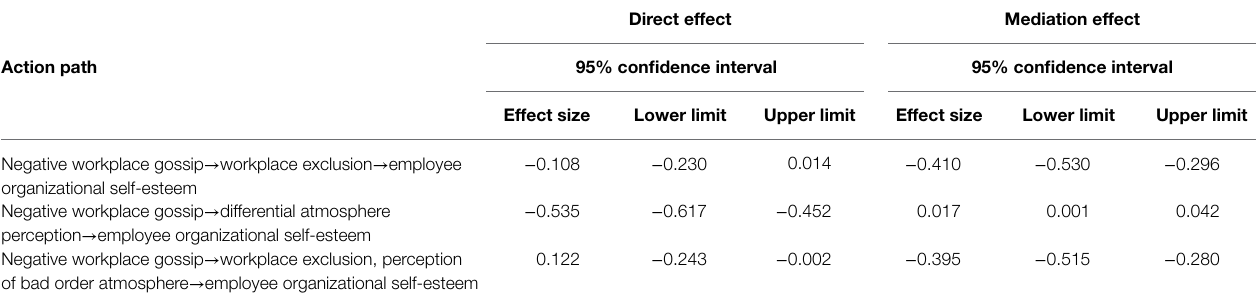
TABLE 5 | Bootstrap analysis results of mediation effect.